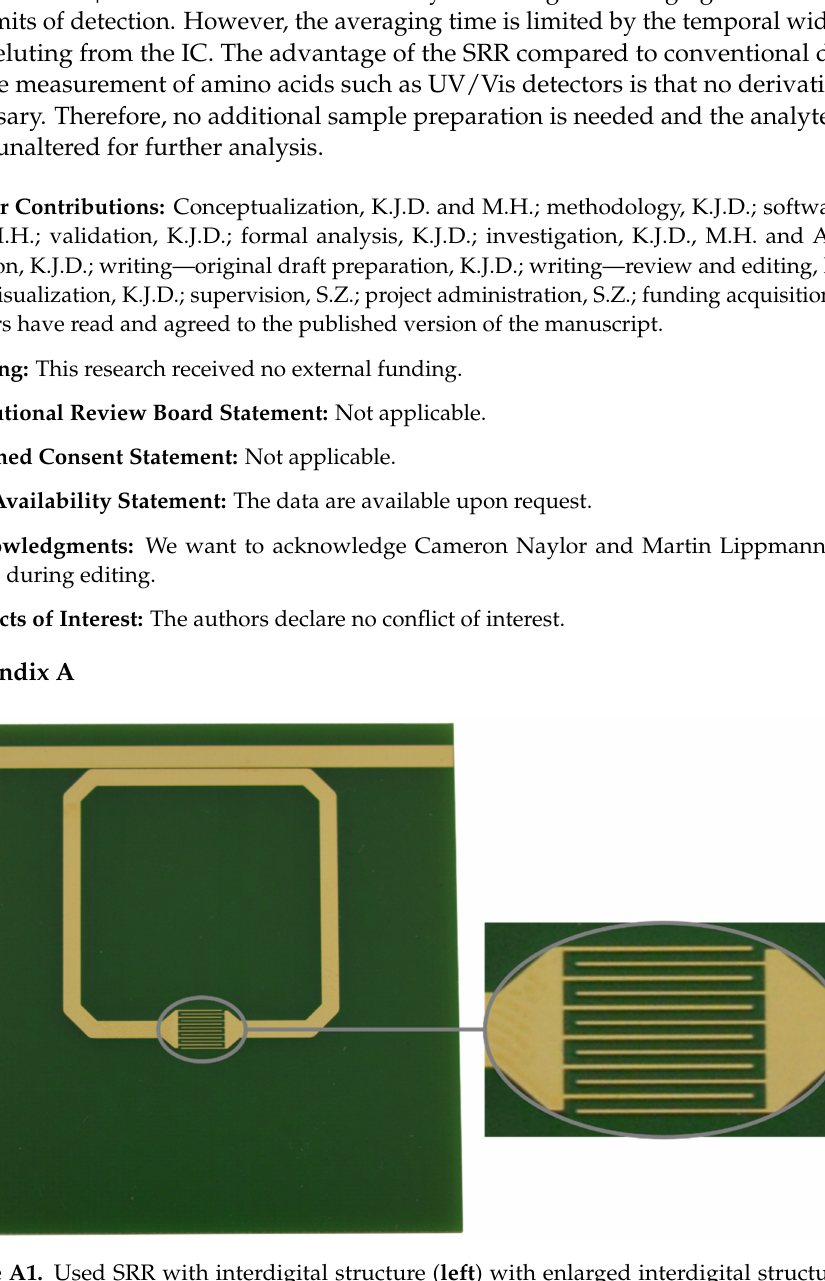
Figure A1. Used SRR with interdigital structure ( left ) with enlarged interdigital structure ( right ) with 6 fingers with a length of 5 mm, 150 µ m width and spacing between